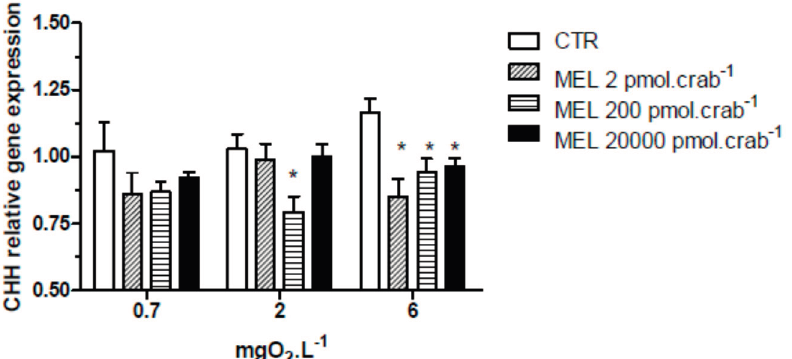
Figure 3. Crustacean Hyperglycemic Hormone (CHH) relative gene expression in the eyestalks of Neohelice granulata exposed for 45 min to three different dissolved-oxygen concentrations (0.7, 2 or 6 mgO 2 ·L − 1 ) and injected with physiological saline (CTR) or melatonin (2, 200 or 20,000 pmol·crab − 1 ). Each point represents the mean ± SE ( n = 3–4). * represents a significant difference ( p < 0.05) from the CTR group. The values are normalized for β -actin gene